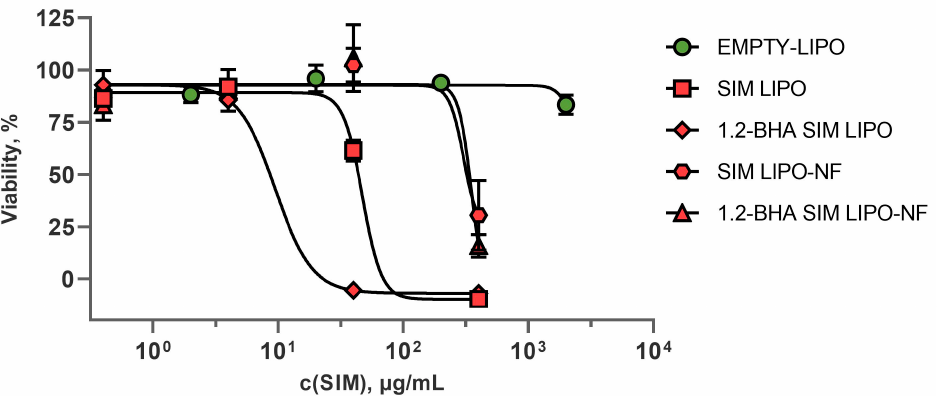
Figure 6. The effects of the formulations with different SIM concentrations on keratinocyte viability. Formulations without and with SIM are indicated in red and green, respectively. The data are presented as means ± SD ( n = 3). Table 5. Half-maximal inhibitory concentration (IC50) values of formulations tested on keratino- cytes.